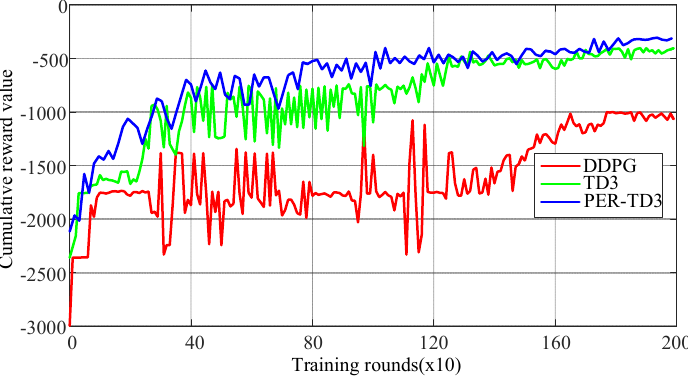
Figure 10 . Cumulative return value.